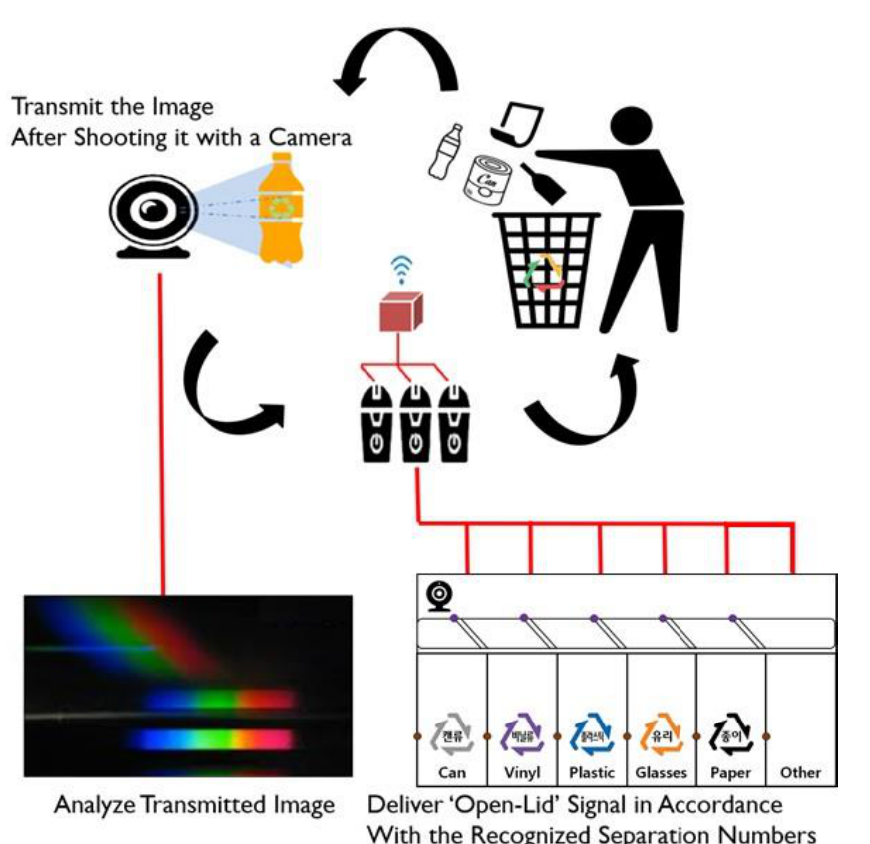
Figure 5. Solution (Image Processing System + Spectroscope) for future implementation.